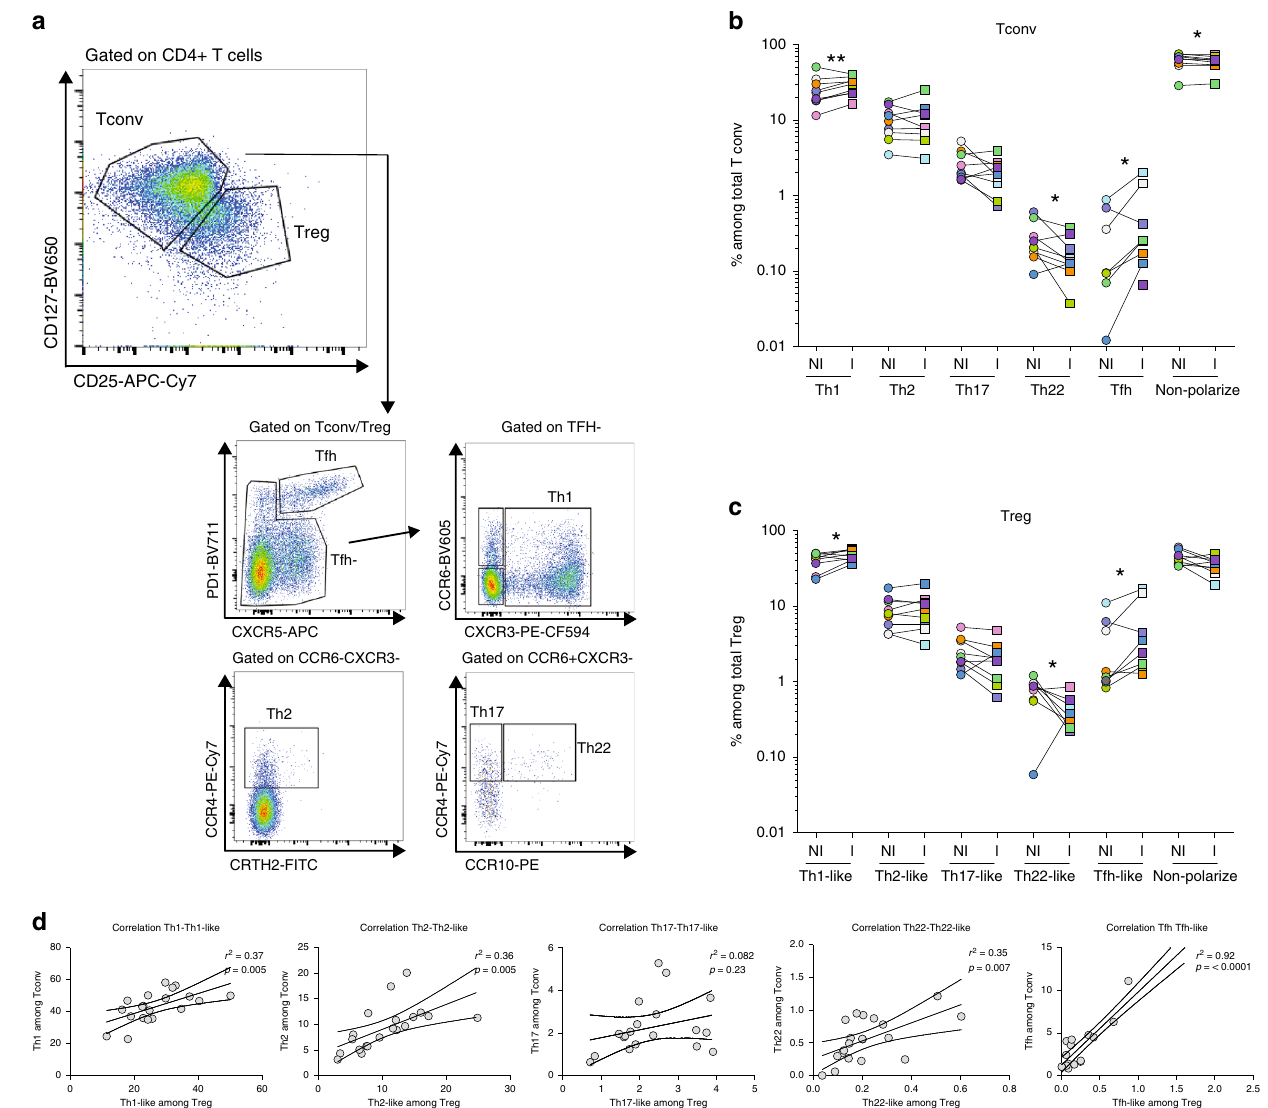
Fig. 4 CD4 + T-cell chemokine receptor patterns in TDLNs. Cell suspensions of TDLNs cells were stained for CD3, CD4, CD127, CD25, PD-1, CXCR5, CCR6, CXCR3, CCR4, CCR10, and CRTH2. a Representative fl ow cytometric analysis of CD4 + T-cell phenotype among gated CD4 + CD127 + CD25 − (Tconv) or CD4 + CD127 low CD25 hi (Treg) cells in TDLNs. b , c Frequency of cells expressing the indicated chemokine receptor combinations among b Tconv (Th1: p = 0.0078; Th22: p = 0.0371; Tfh: p = 0.0391; non-polarized: 0.0371in NI vs I TDLNs) and c Tregs (Th1-like: p = 0.0195; Th22-like: p = 0.0391; Tfh-like: p = 0.0312) in TDLNs. Wilcoxon matched-pairs signed rank test ( n = 10) d Scatter plots and linear regression graphs of the correlation between the frequency of Th1 vs Th1-like, Th2 vs Th2-like, Th17 vs Th17-like, Th22 vs Th22-like, and Tfh and Tfr populations. * P < 0.05; ** P < 0.01 in TDLNs ( n = 20). The statistical signi fi cance of the correlation was determined using the Pearson ’ s correlation. Non-polarized: CD4 + T cells negative for the assessed chemokine